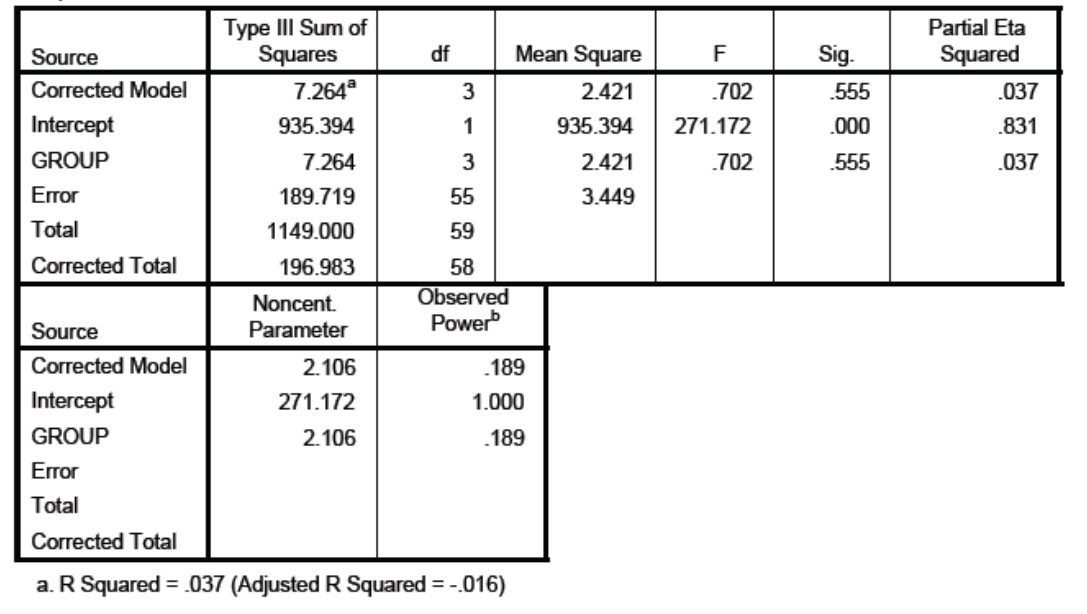
Figure B.15. ANOVA analysing enjoyment levels between the four groups of participants using raw data for participants who correctly indicated their